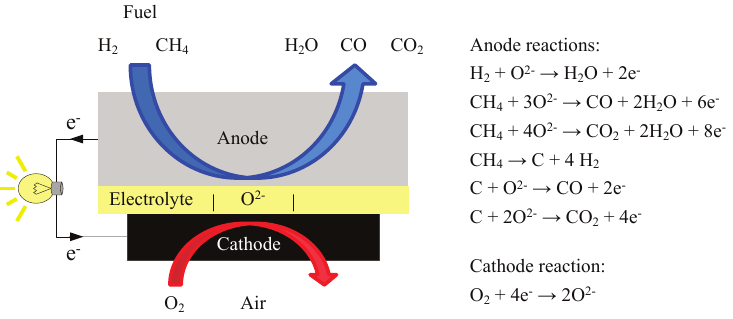
Figure 1. Schematic of solid oxide fuel cell operating